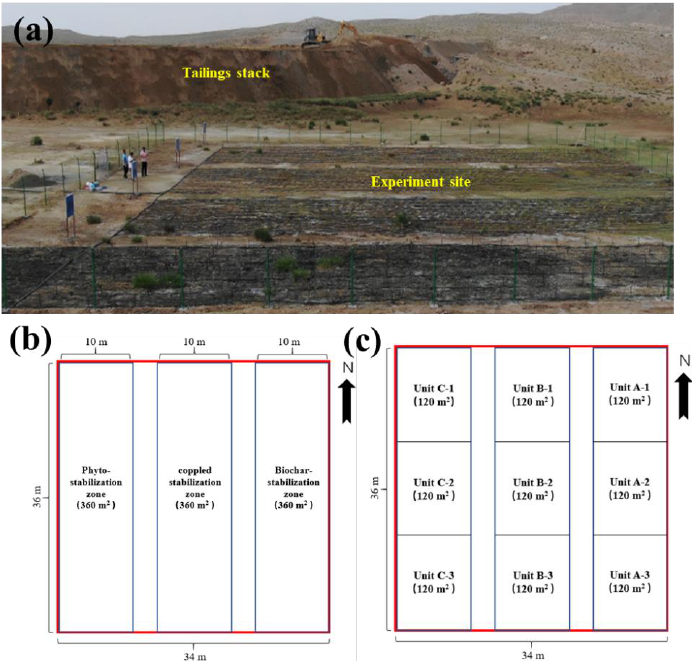
Figure 1. Location of the trial site and site division: ( a ) panoramic view of experiment site; ( b ) division of different stabilization zones in the trial site; and ( c ) distribution of sampling